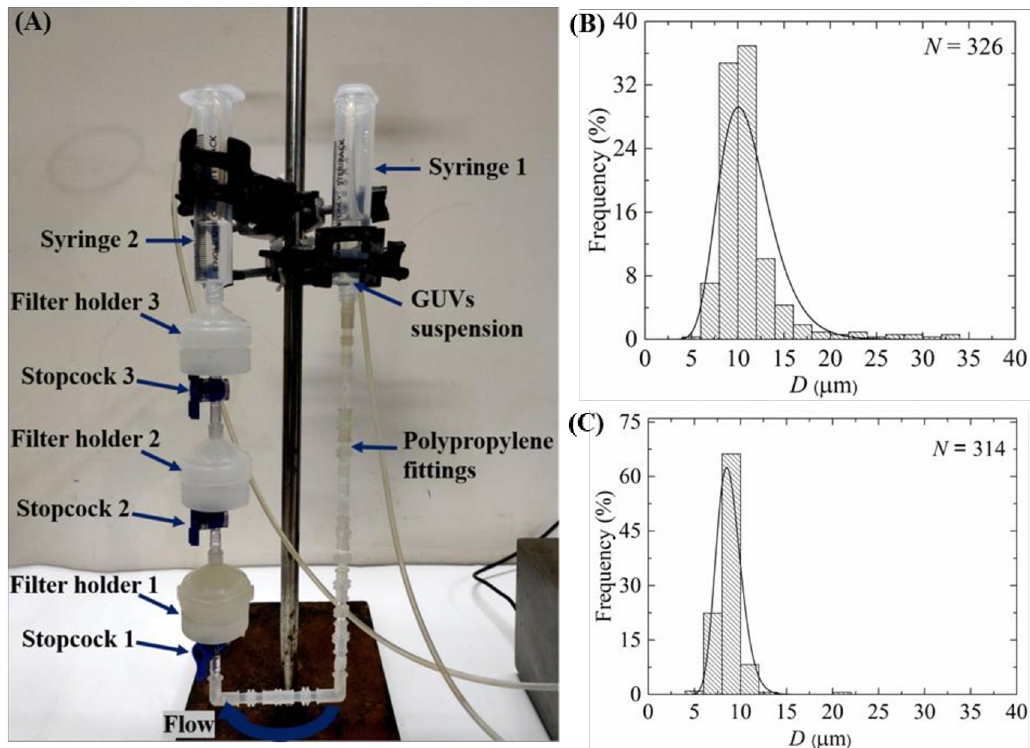
Fig 12. Purification of GUVs using an extra filtration with dual filtration technique. (A) The arrangement of an extra filtration with dual filtration. The size distribution histogram of 40%DOPG/60%DOPC-GUVs in filter holder 2 (B) and filter holder 3 (C). The purification was performed at flow rate 1 mL/min for 1 h. The solid line of B and C corresponds to fitting with Eq 1.